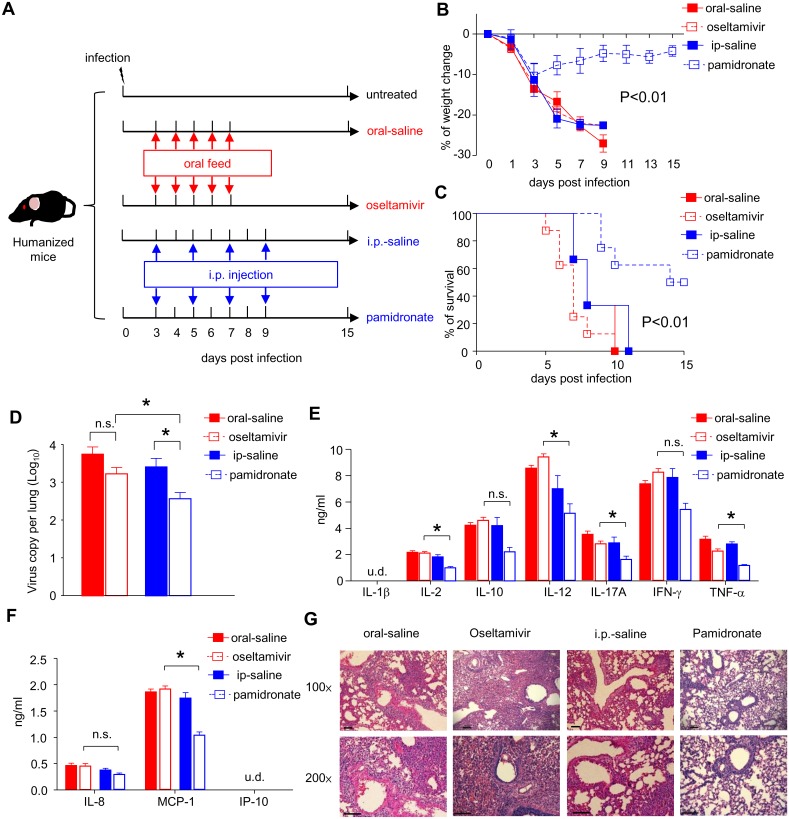
Therapeutic effects of Pamidronate and oseltamivir by delayed treatment.Humanized mice were infected with H7N9 virus i.n. at 106 TCID50 in 25μl saline solution on day 0. Pamidronate were injected i.p. on day 3 (10mg/kg), 5, 7 and 9 (5mg/kg per dose) post infection whereas control mice were fed with oseltamivir by oral gavage daily for 5 consecutive days (day 3~7, 50mg/kg each dose) (A). The weight change (B) and survival (C) of infected mice (8 mice for pamidronate treatment group, 8 mice for oseltamivir treatment group, 6 mice for each saline-treated group) were monitored and recorded till day 15 post infections. On day 7 post infection, lungs from different groups were harvested and the viral loads (D) and the levels of human pro-inflammatory cytokines (E) and chemokines (F) in the supernatants of homogenized lung tissue were determined (n = 5). *p<0.05; n.s., no significance; u.d., undetectable; detection limits: IL-8: 14~10,000pg/ml; MCP-1: 55~40,000pg/ml; IP-10: 17~12,500pg/ml; IL-1β, IL-2, IL-10, IL-12, IFN-γ, and TNF-α: 27~20,000pg/ml; IL-17A: 14–10,000pg/ml. (G) Representative histological sections of the lung tissues from H7N9 virus-infected mice receiving pamidronate or oseltamivir treatment were stained with hematoxylin and eosin. Bars, 100μm. The data are representative of three independent experiments.